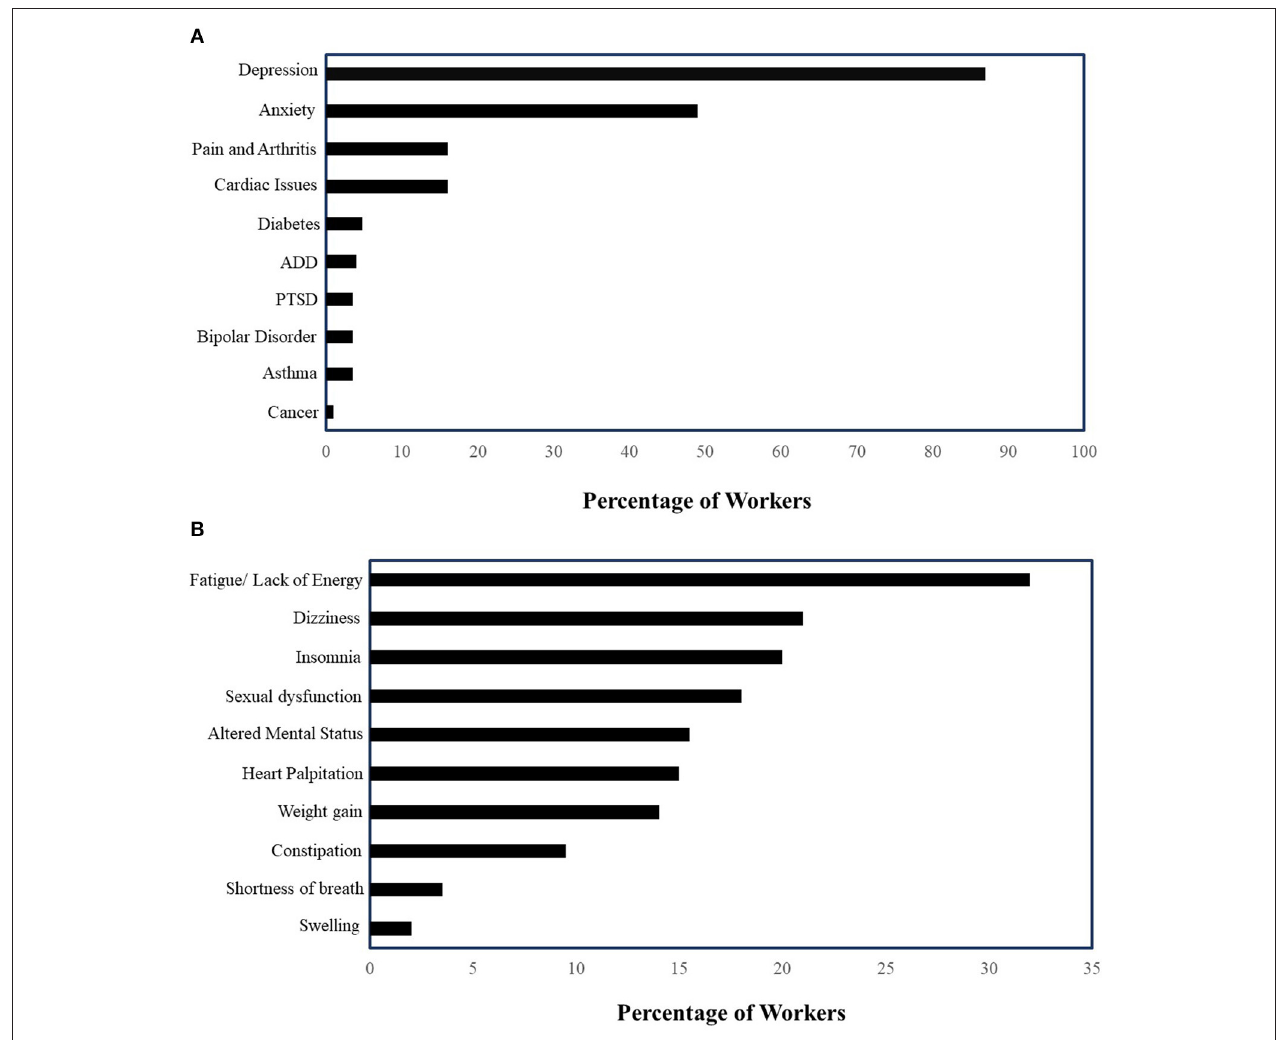
FIGURE 1 | (A) Prevalence of mental health conditions in patients on mental health-related disability ( n = 84) (PTSD, Post-traumatic Stress Disorder; ADD, Attention Deficit Disorder). (B) Medication-related side effects in patients on mental health-related disability ( n = 84).